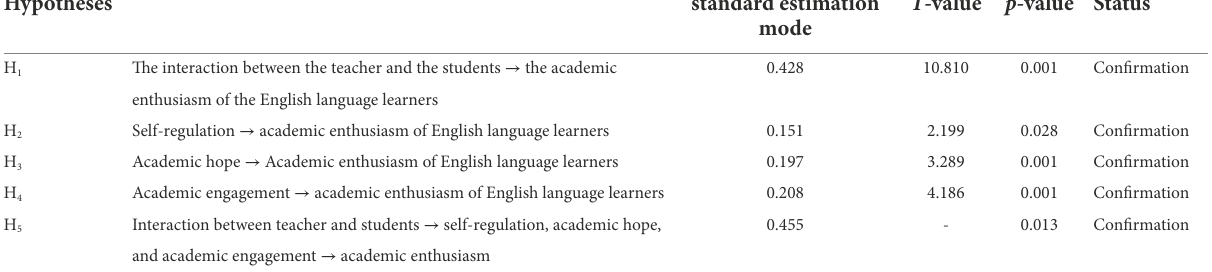
TABLE 5 Relationships between research